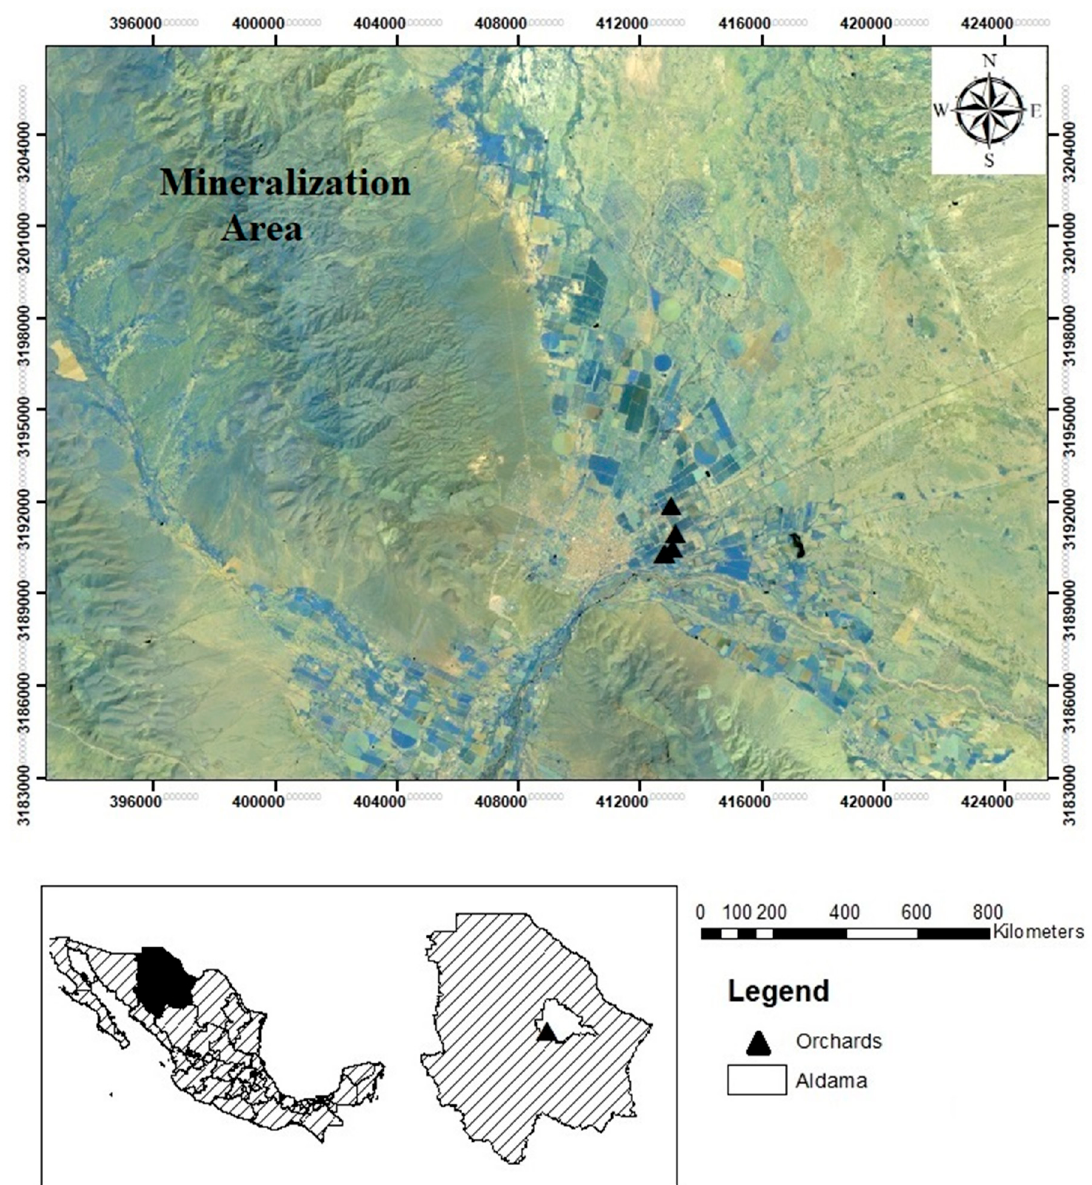
Figure 1. Location of the area of study and the sampling points selected in Aldama, Chihuahua.